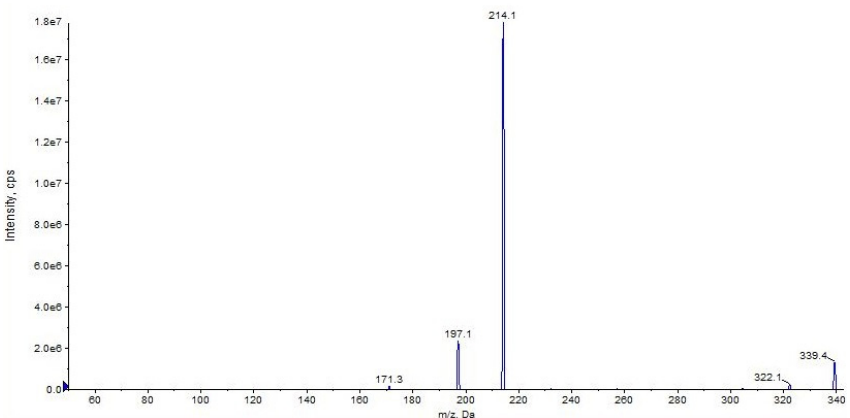
Figure 5. Product ion scan of URB597 compound obtained by QqQ. Exponential scale to base 10. The main fragmentation pathways are driven by α -cleavages to the carbonyl moieties (Table 2, Figure 6).